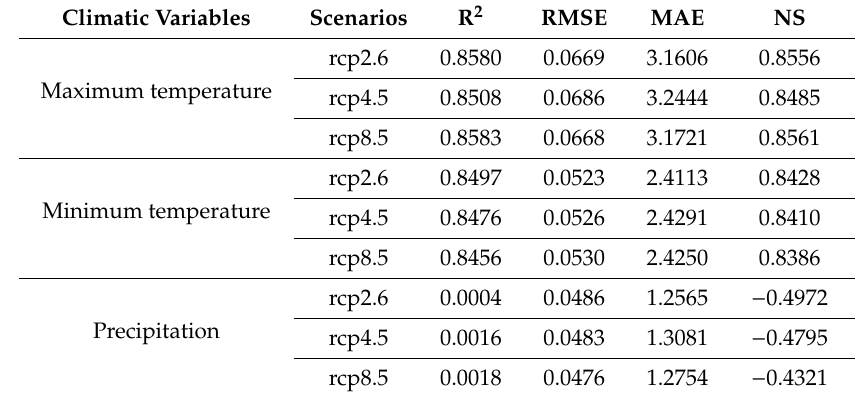
Table 5. Performance of the model in the baseline period (1986–2015) using the statistical error